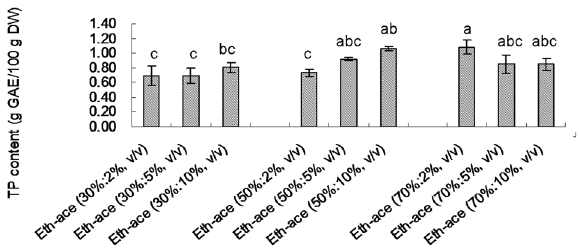
Figure 1. Effect of different proportion of ethanol and acetic acid combinations on TP content. Means of each two treatments were compared using least significant difference (LSD) statistic method. Lowercase letters a, b, and c were used to mark significance of difference ( p < 0.05). Same letters between treatments mean insignificant difference. Different letters between treatments mean significant